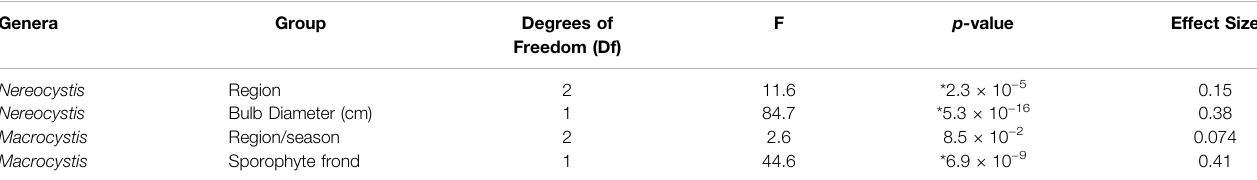
TABLE 5| ANCOVA resultsfortheeffect ofregion(andseasons forgiant kelp)ontheslopeandinterceptsoftherelationshipbetweenthedependentvariable(bulb diameter or frond count) and canopy biomass. Bull kelp regions are Monterey, Mendocino, and Alaska. Giant kelp regions/seasons are Santa Barbara (all), Santa Barbara (summer), and Montery. *denotes signi fi